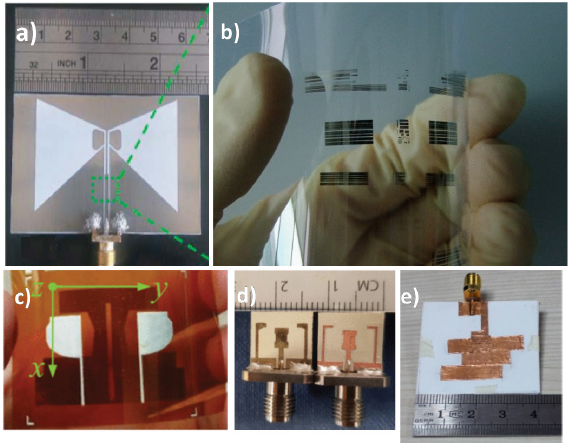
Figure 4. Fabricated antenna prototypes on: ( a ) polyethylene terephthalate (PET) [67], ( b ) polyethylene naphthalate (PEN) [70], ( c ) Polyimide [59], ( d ) liquid crystal polymer (LCP) [82], and ( e ) paper [80] substrates.